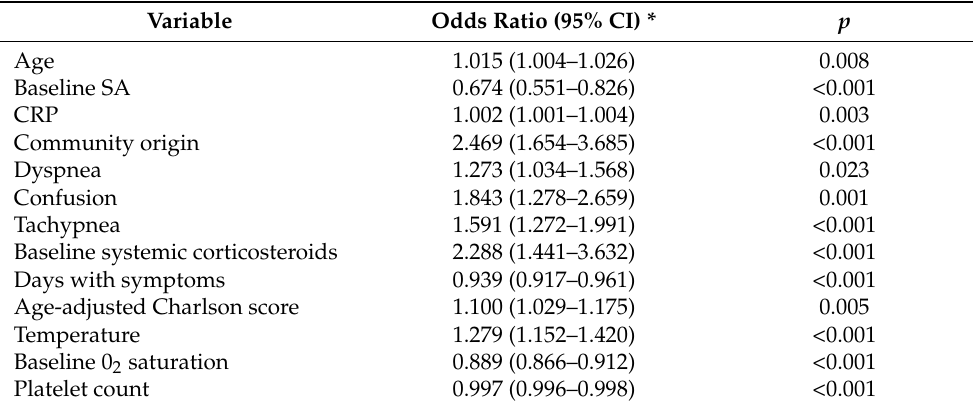
Table 3. Multivariate logistic regression model for the additive form (SA +